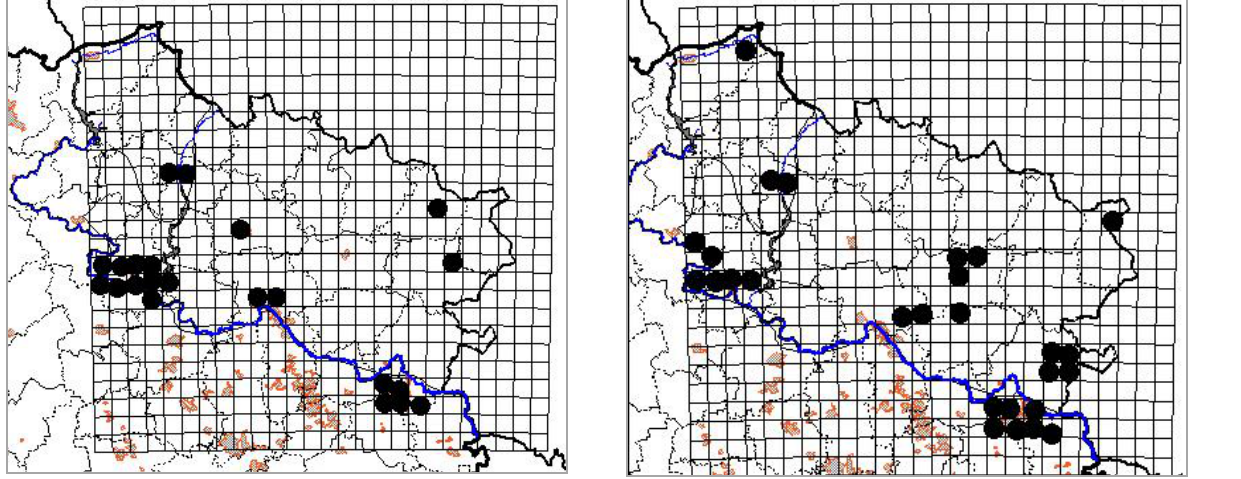
Fig. 17. The map of the distribution of Diplotaxis tenuifolia (L.)